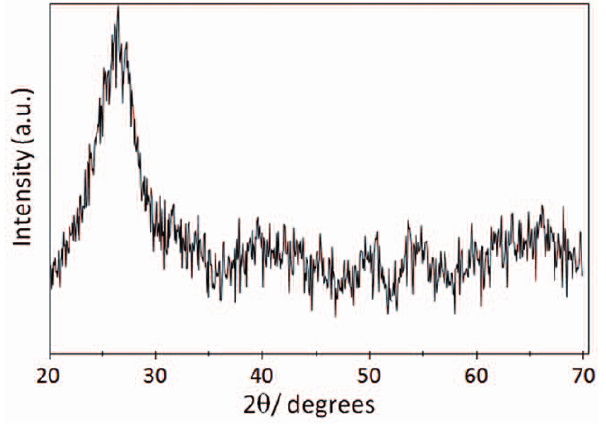
Figure 6. XRD pattern of biosynthesized CdTe QDs. CdTe NPs were purified from E. coli gshA cells as described in Methods and the presence of crystalline structures analyzed by XRD.